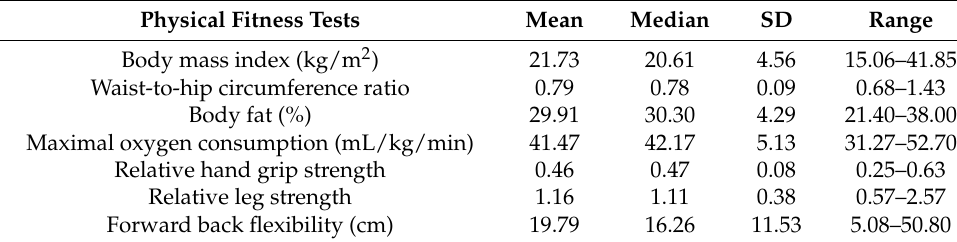
Table 3. The results of physical fitness tests ( n =